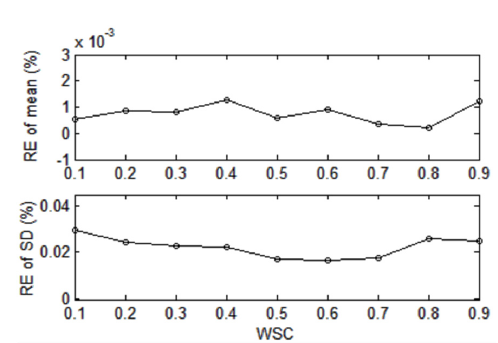
Figure 9. ε P 1 ´ 2 µ , ε P 1 ´ 2 σ of 3-order SG-PLF method under different WSC.